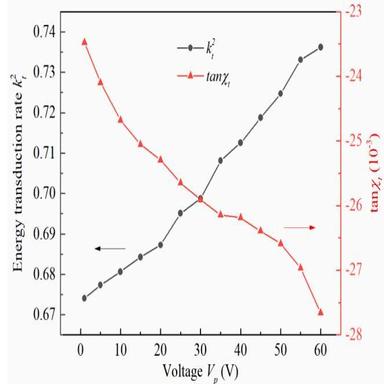
The energy transduction rate k2 tand loss factor tanχt of the PMN-PT composite as a function of the AC driving voltage.